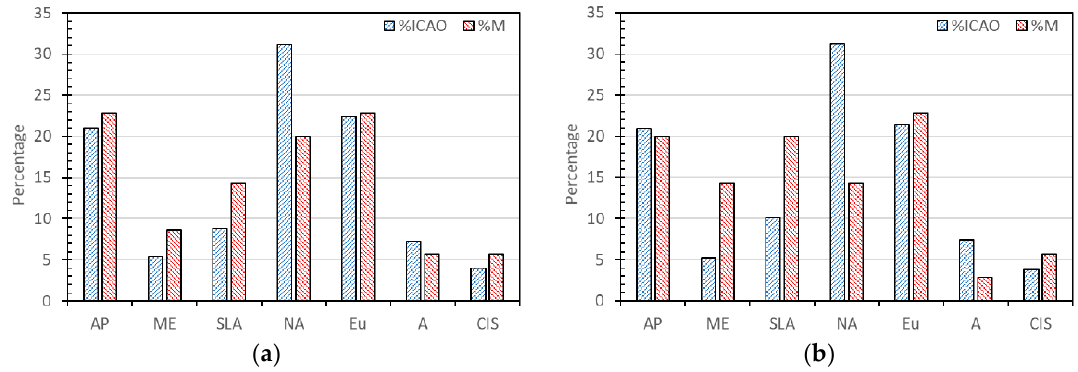
Figure 2. Distribution of world region for accidents with maintenance contributions: ( a ) region of the operator (ROp); ( b ) region where the accident occurred (ROc).